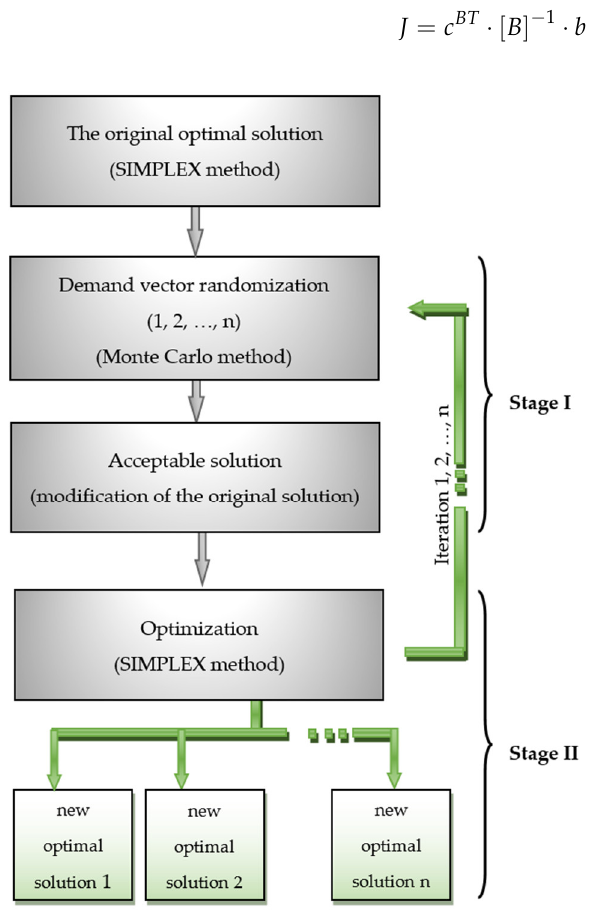
Figure 1. The flowchart of the algorithm of the proposed method.